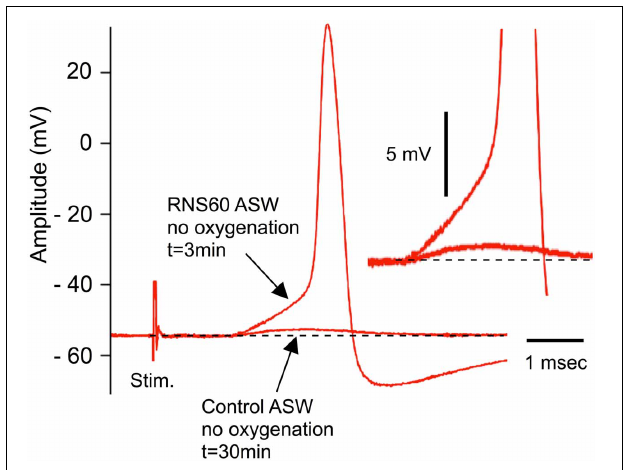
FIGURE 1 | Example of recovery of evoked transmitter release by RNS60 ASW in a hypoxic synapse following electrical stimulation of the presynaptic terminal. Note small subthreshold synaptic potential after 30min of hypoxia (lower arrow) and EPSP (upper arrow) and action potential elicited 3min after superfusion with RNS60 ASW. Insert, amplitude magnification showing detail of the EPSP onset indicating change in amplitude without a change in release latency.